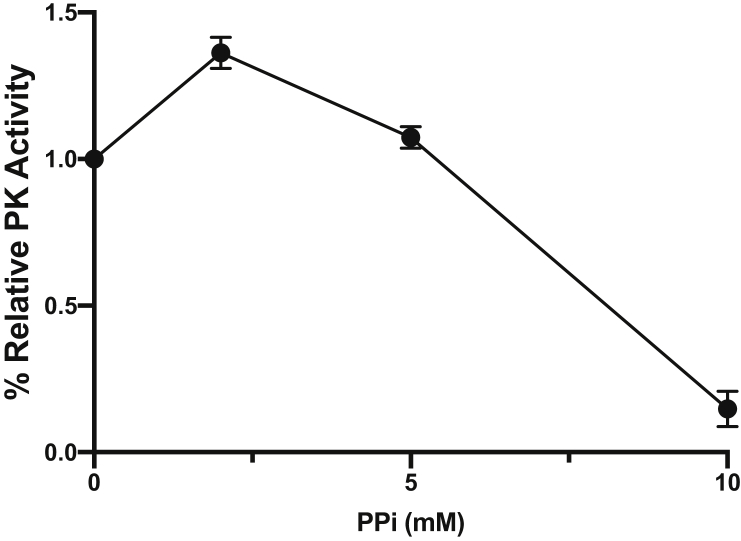
Influence of PPi concentration on pyruvate kinase activity. PYK activity was measured in the cell-free extract of the homoethanologen strain of T. saccharolyticum (LL1328) with addition of 2 ​mM, 5 ​mM or 10 ​mM PPi. Relative activity was calculated based on the no-inhibitor condition. Error bars represent one standard deviation (n ​= ​2).